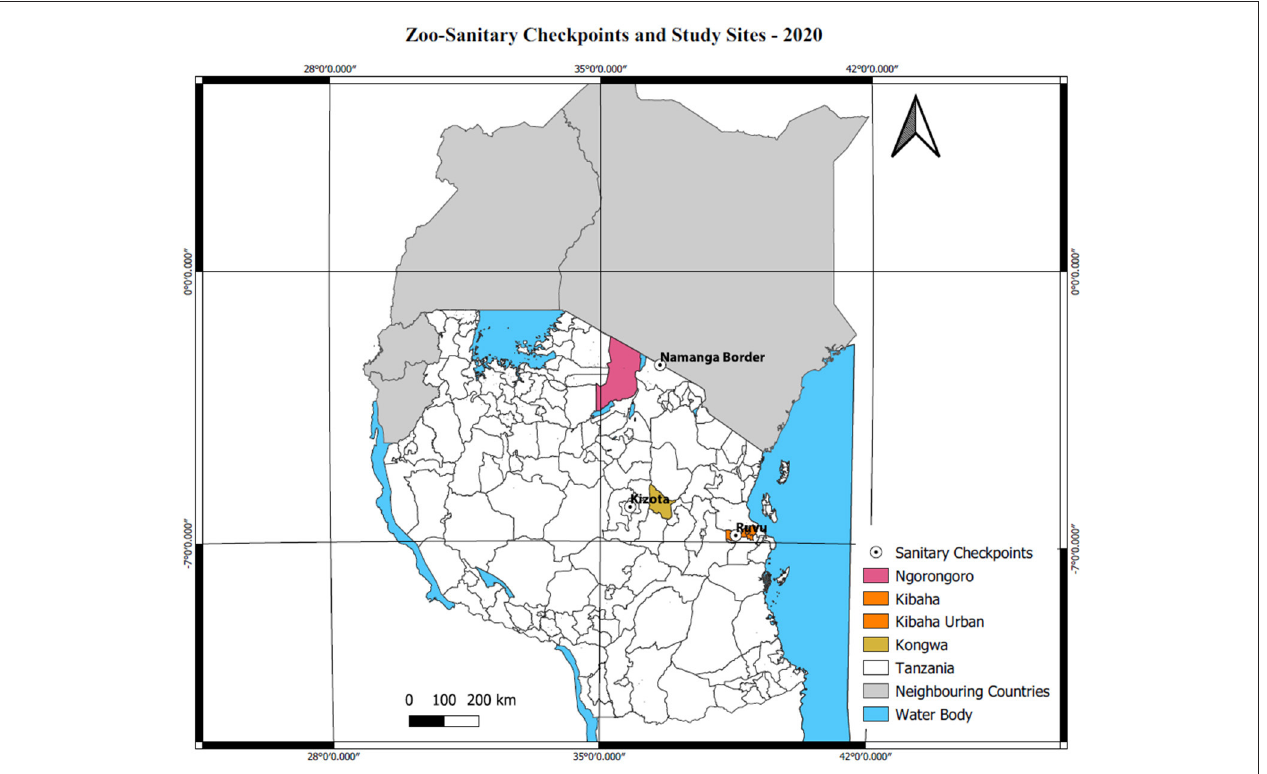
FIGURE 2 | Map of the study districts and zoo-sanitary checkpoints [Personal creation using QGIS version 3.12.3-Bucure¸sti (14)].